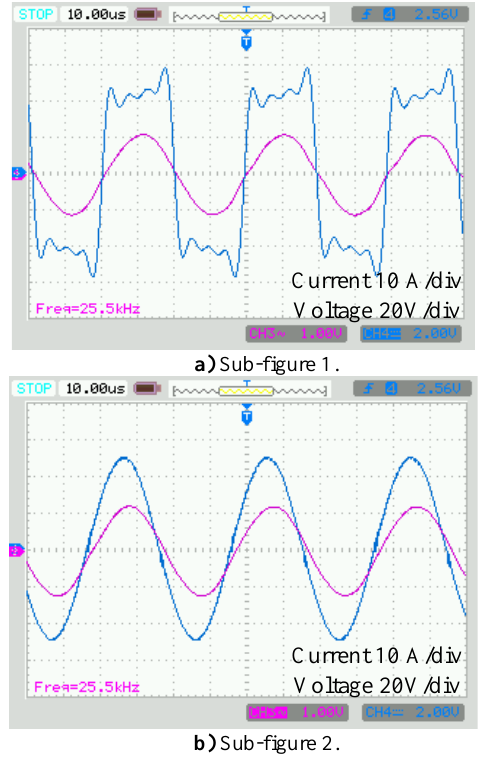
Figure 10. For 50 V DC bus voltage and 25.5 kHz switching frequency voltage (blue) and current (purple) at the input (a) and load resistance ( R L )